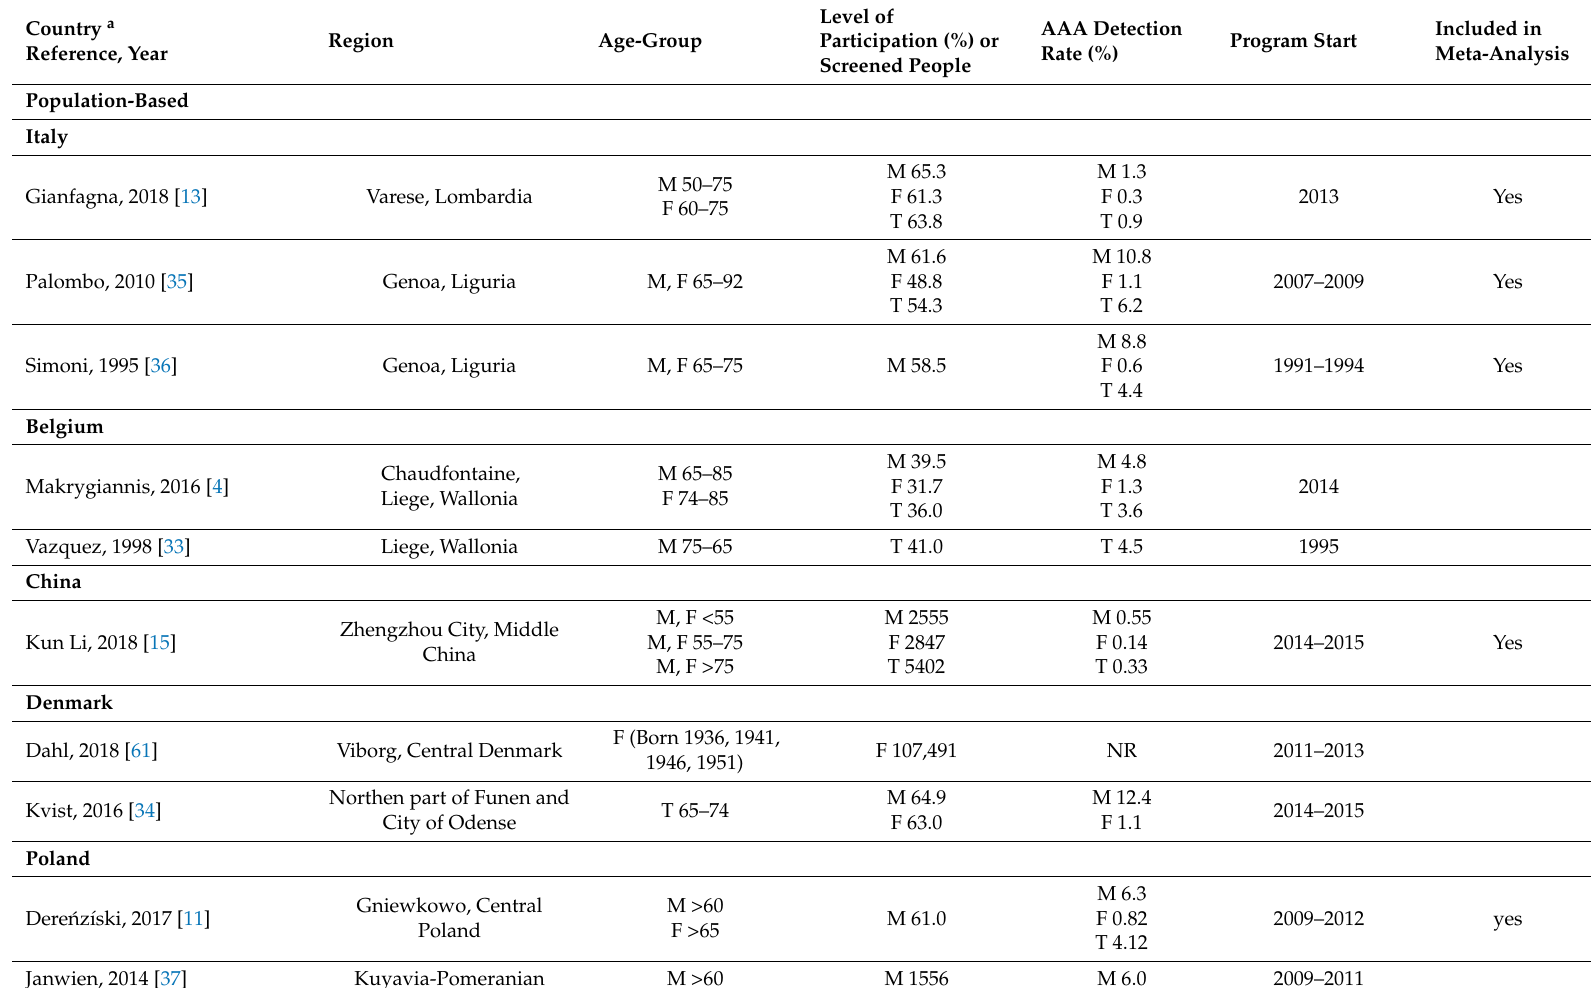
Table 1. Characteristics of the studies included in the Systematic